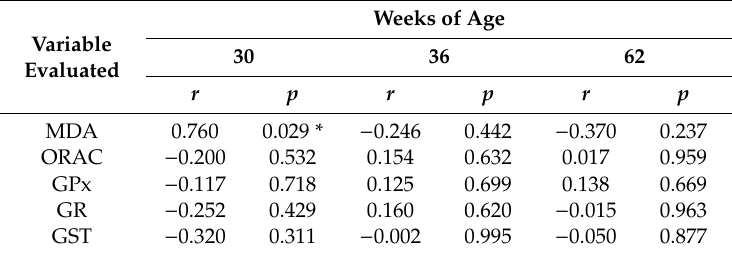
Table 2. Correlations between body weight with oxidative stress, non-enzymatic antioxidant capacity and enzymatic antioxidant activities in roosters of di ff erent ages.